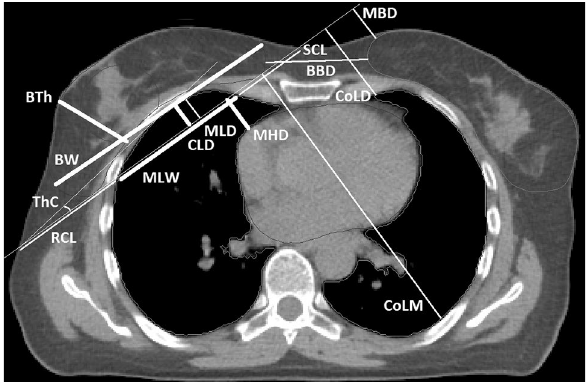
Figure 1. Anatomic measures scored from patients’ CT images. Cranio-caudal measures are not